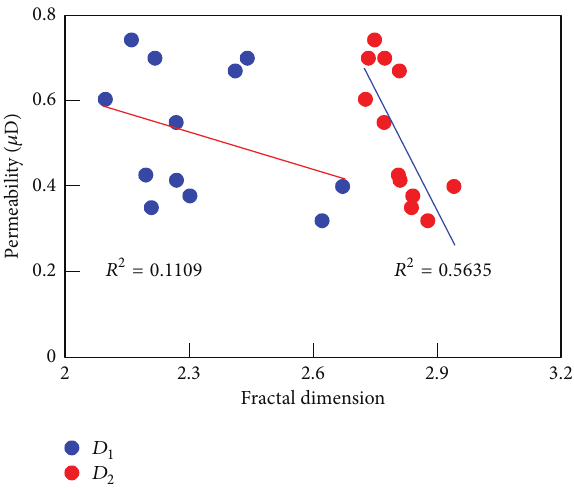
Figure 7: Relationship between fractal dimension and